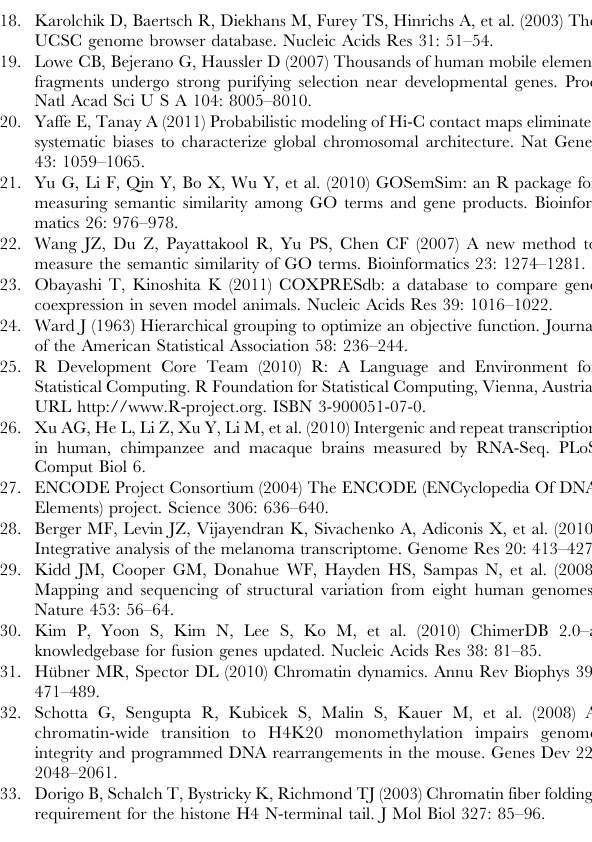
Figure S19 Spatial proximity values plotted against sums of DNAse sensitivity values. Markers represent aggregated sample values, the line visualizes the regression model. (TIFF) Figure S20 Spatial proximity values plotted against sums of methylation state values. Markers represent aggregated sample values, the line visualizes the regression model. (TIFF) Figure S21 Spatial proximity values plotted against sums of histone modifications values. Markers represent aggregated sample values. (TIFF) Figure S22 Spatial proximity values plotted against differences of expression values. Markers represent aggre- gated sample values, the line visualizes the regression model. (TIFF) Figure S23 Spatial proximity values plotted against differences of DNAse sensitivity values. Markers represent aggregated sample values, the line visualizes the regression model. (TIFF) Figure S24 Spatial proximity values plotted against differences of methylation state values. Markers represent aggregated sample values, the line visualizes the regression model. (TIFF) Figure S25 Spatial proximity values plotted against differences of histone modifications values. Markers represent aggregated sample values. (TIFF)